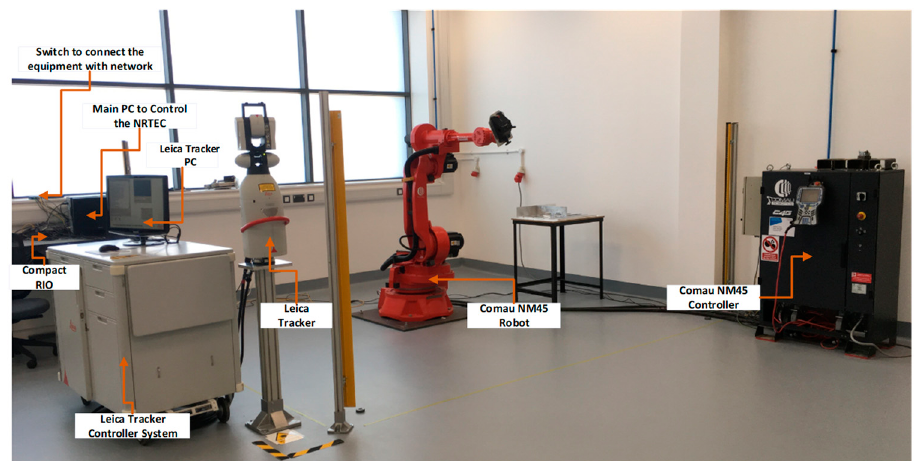
Figure 7. NRTEC physical cell.